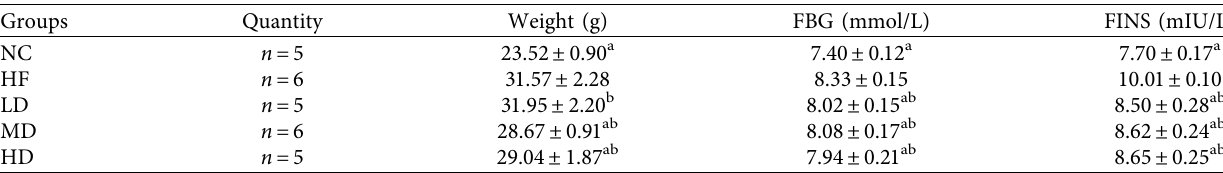
Table 2: Comparison of body weight, FBG, and FINS in each group (means ± SD). The sample size of NC, LD, and HD groups was reduced from 6 to 5 due to improper operation by the experimenter. The weight and FBG of mice were measured once a week. The levels of FINS were measured at the termination of the study. a Compared with the HF group, the difference was statistically significant ( P < 0 . 05); b compared with the NC group, the difference was statistically significant ( P < 0 . 05).